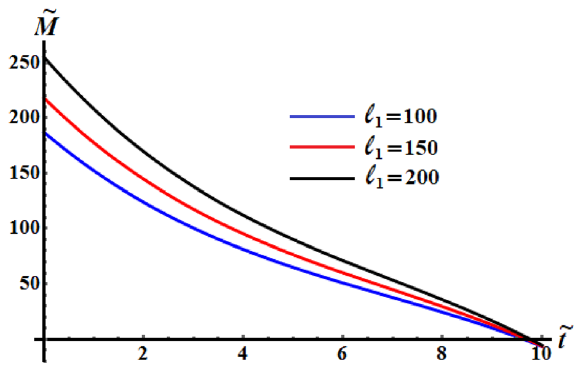
Figure 6. Displays the change of ˜ M over time when (ℓ 2 , ℓ 3 ) = ( 150, 50 ) kg m 2 s − 1 at ℓ